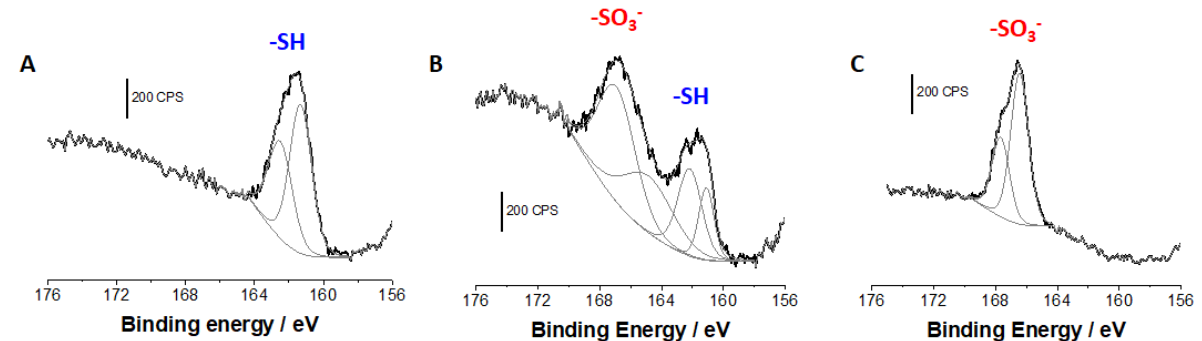
Figure 2. S2p core level spectra of a mercaptopropyl-functionalized mesoporous silica film (ob- tained by EASA from a sol prepared from 20/80 MPTMS:TEOS), respectively, recorded before ( A ), after 10 minutes ( B ), and after 30 minutes ( C ) of chemical oxidation with hydrogen peroxide (30%) in 0.1 M H 2 SO 4 .